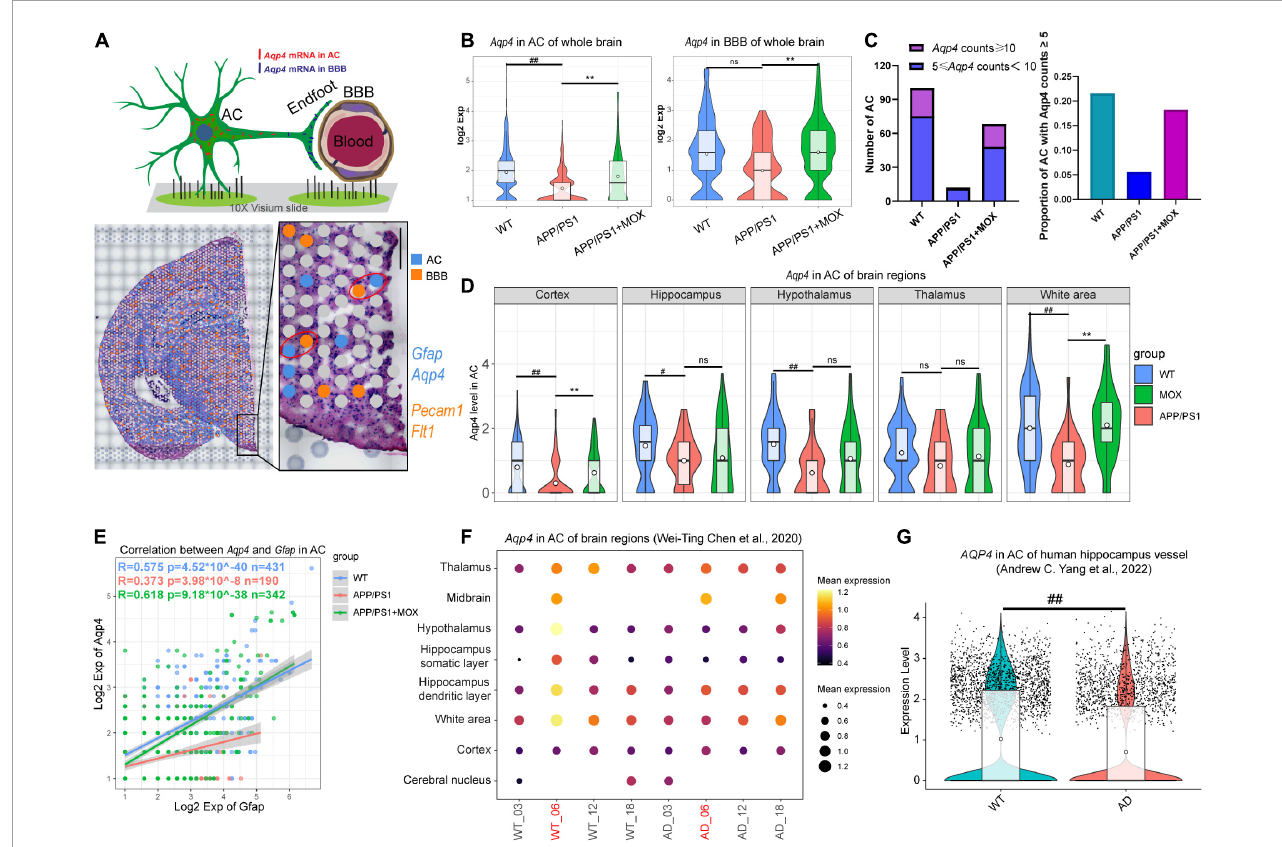
FIGURE2 The reduction of Aqp4 expression in perivascular astrocytes (AC) and the blood-brain barrier (BBB) in APP/PS1 mice. (A) Schematic diagram of screening methods for perivascular astrocytes. Gfap and Aqp4 represent the signature genes of AC, while Pecam1 and Flt1 represent the signature genes of the BBB. (B) Violin plots of Aqp4 expression in BBB and AC. (C) Barplots indicating the number and proportion of AC with high Aqp4 expression in each group. (D) Violin plots of Aqp4 expression in AC of different brain regions. (E) A scatter plot with a linear fit line showing the correlation between Aqp4 expression and Gfap expression in AC of each group. R, Pearson’s correlation coefficient; p, Pearson’s correlation test P -value. (F) Bubble plot of Aqp4 expression in AC of different age WT and AppNL-G-F mouse brain. (G) Aqp4 expression in AC of the human hippocampus. One-way ANOVA test with post-test # P < 0.05, ## P < 0.01, APP/PS1 vs. WT; ∗∗ P < 0.01, APP/PS1 + MOX vs. APP/PS1; ns. P >